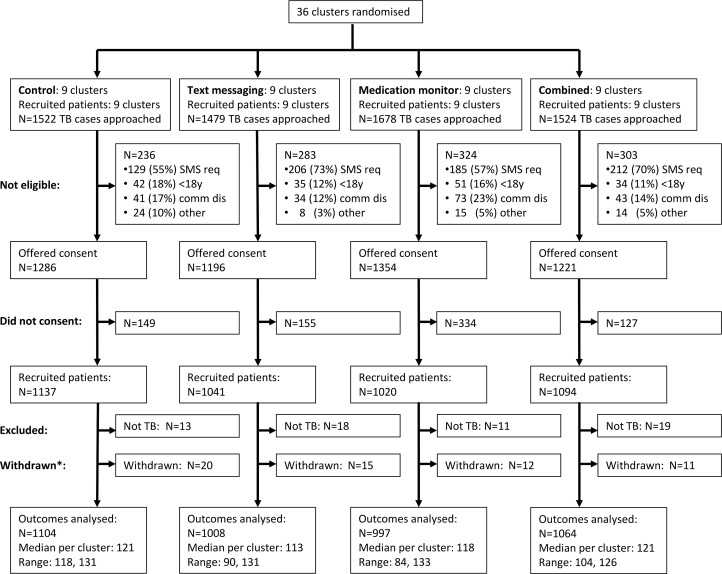
Cluster-level CONSORT diagram.Reasons for non-eligibility: SMS req = unable to use mobile phone after training; <18y = less than 18 y of age; comm dis = communication disability. *Withdrew from the study but continued treatment in the local Center for Disease Control and Prevention.